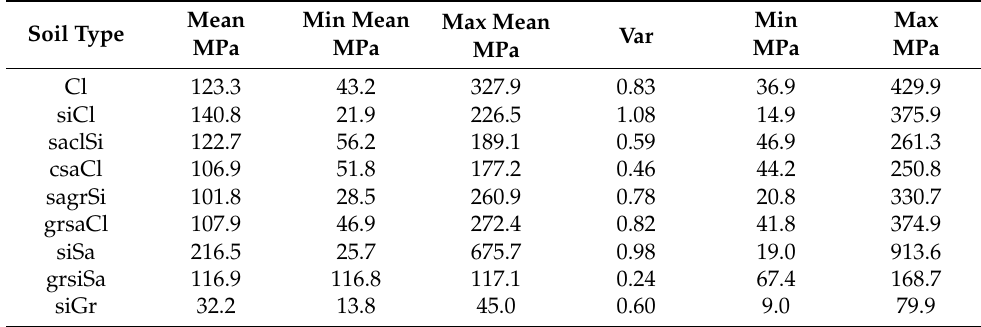
Table 2. Statistics of resilient modulus M r,eff for individual soil classes.